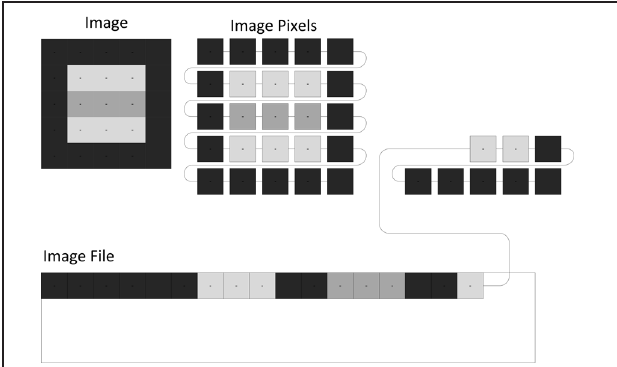
FIGURE 1 | Unraveling the pixels of an image. A two-dimensional image consists of pixels that must be rearranged into a one-dimensional line before the pixel values can be stored in a